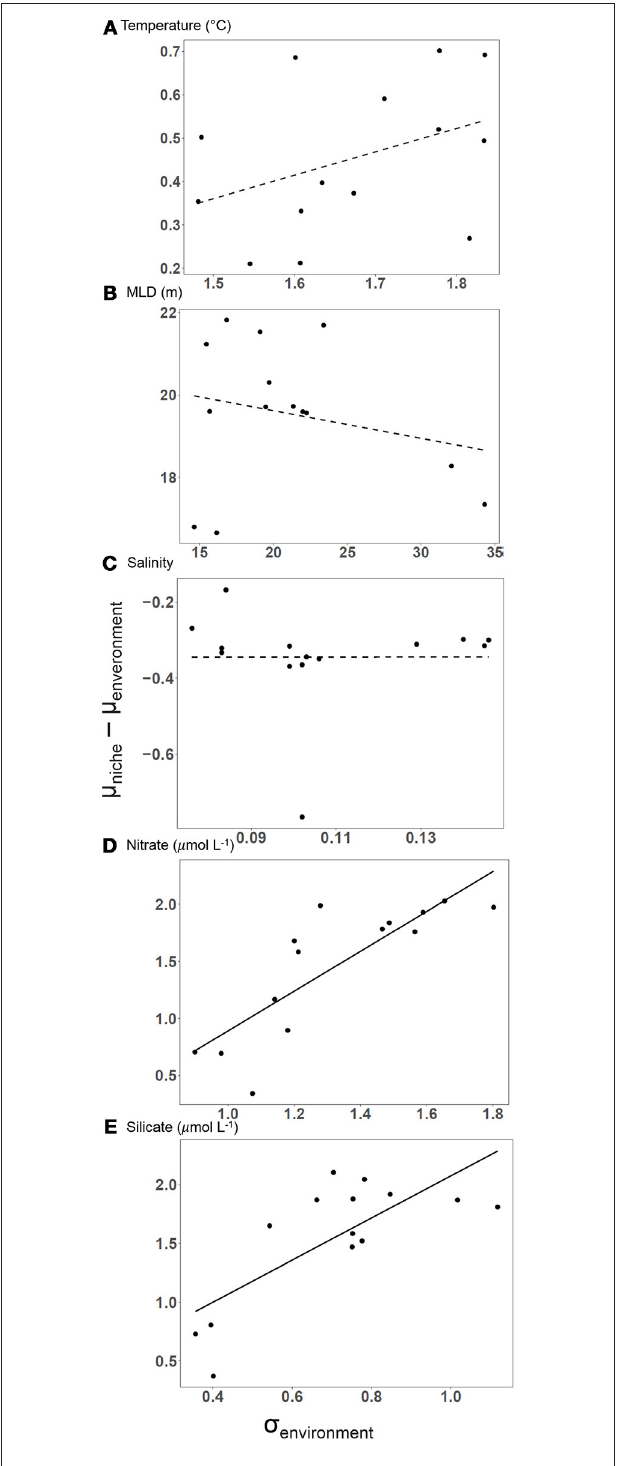
FIGURE 4 | The difference between the community average of mean realized niches and the mean environmental conditions for each 4-year window as a function of the standard deviation of environmental conditions. For nitrate and silicate concentration (D, E) increasing variability in the environment led tolargerdifferencesbetweenmeanenvironmentalconditionsandmeanrealized